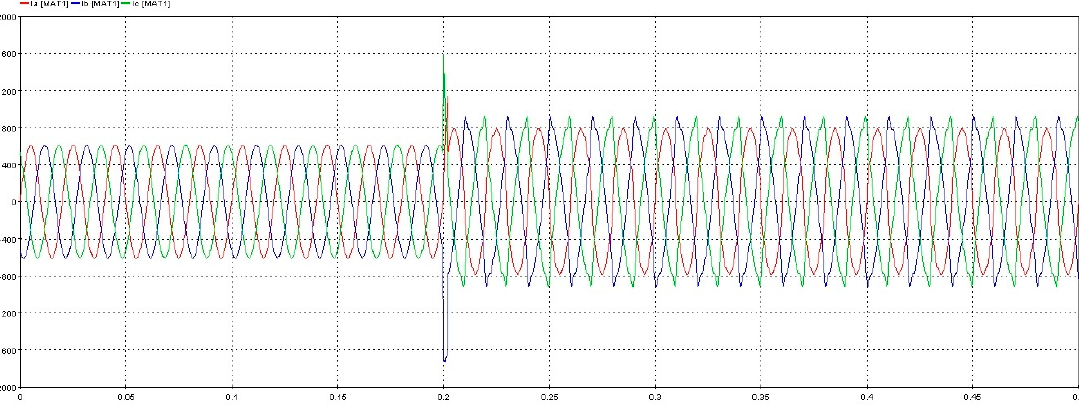
Figure 14. Current waveform under non-linear load.